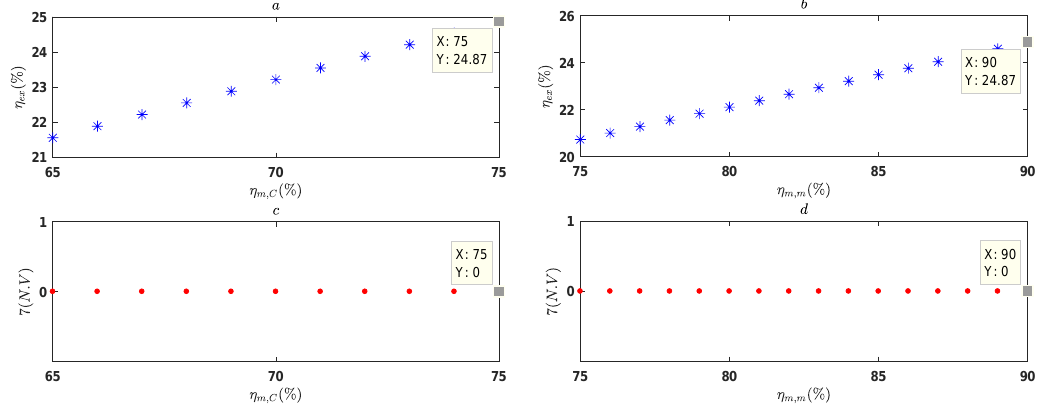
Figure 13. Variation of global exergy efficiency and number of violated constraints with compressor ( a , c ) and pneumatic motor ( b , d ) isentropic efficiency at optimal point.